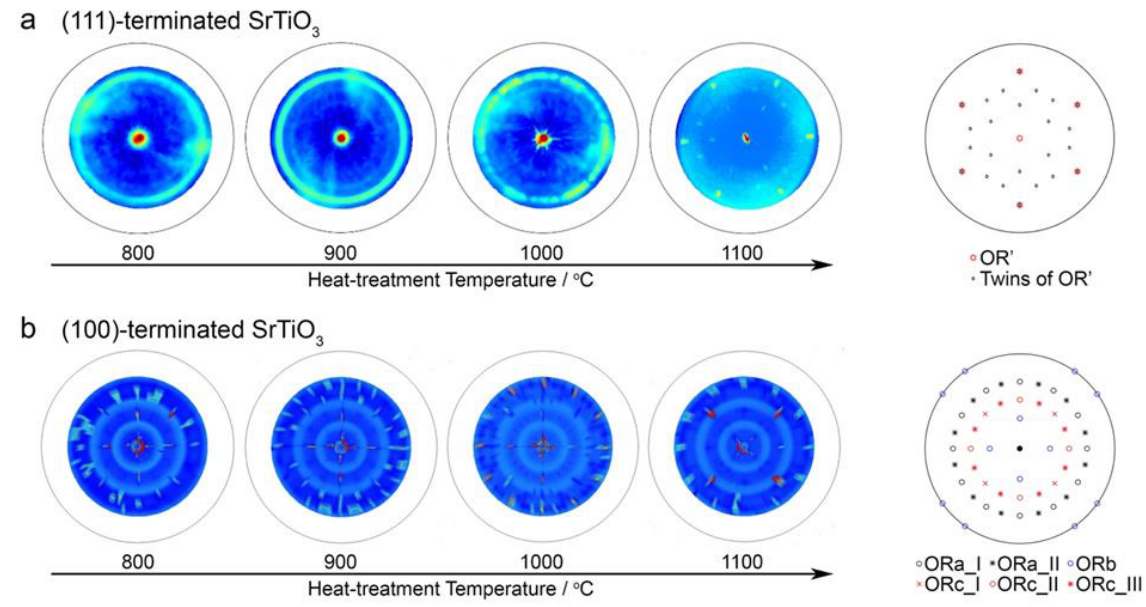
Figure 3. {111} Au pole figures measured by X-ray diffraction (XRD) for (111)-terminated SrTiO 3 ( a ) and (100)-terminated SrTiO 3 ( b ) substrates subjected to a heat treatment at 800, 900, 1000, and 1100 ◦ C. The simulated pole figures based on the proposed ORs are shown to further support these ORs.